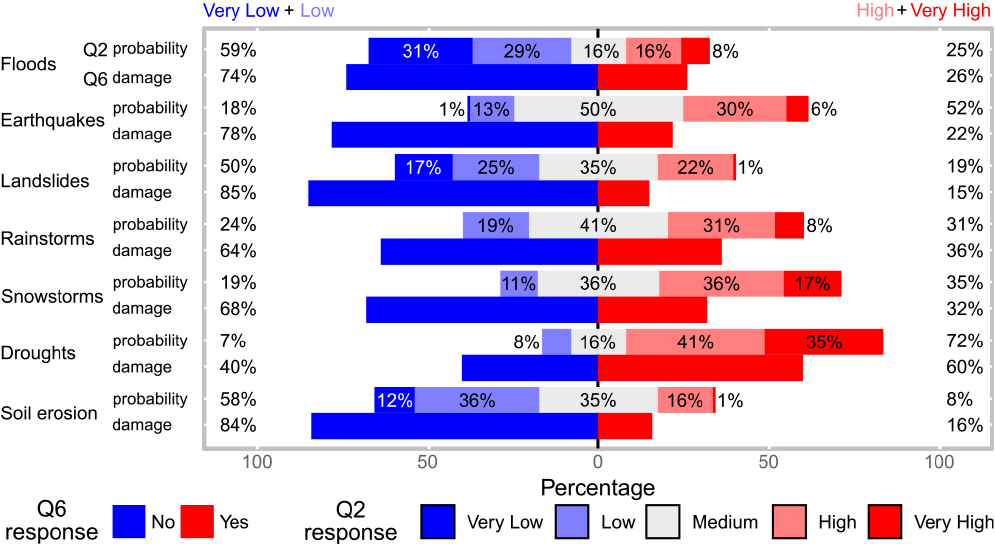
Figure 9. Likert plot of the stakeholders’ responses regarding the perception of the probability of natural hazard appearance in the local community (Q2) and the experience of them producing damage to their person/household/income